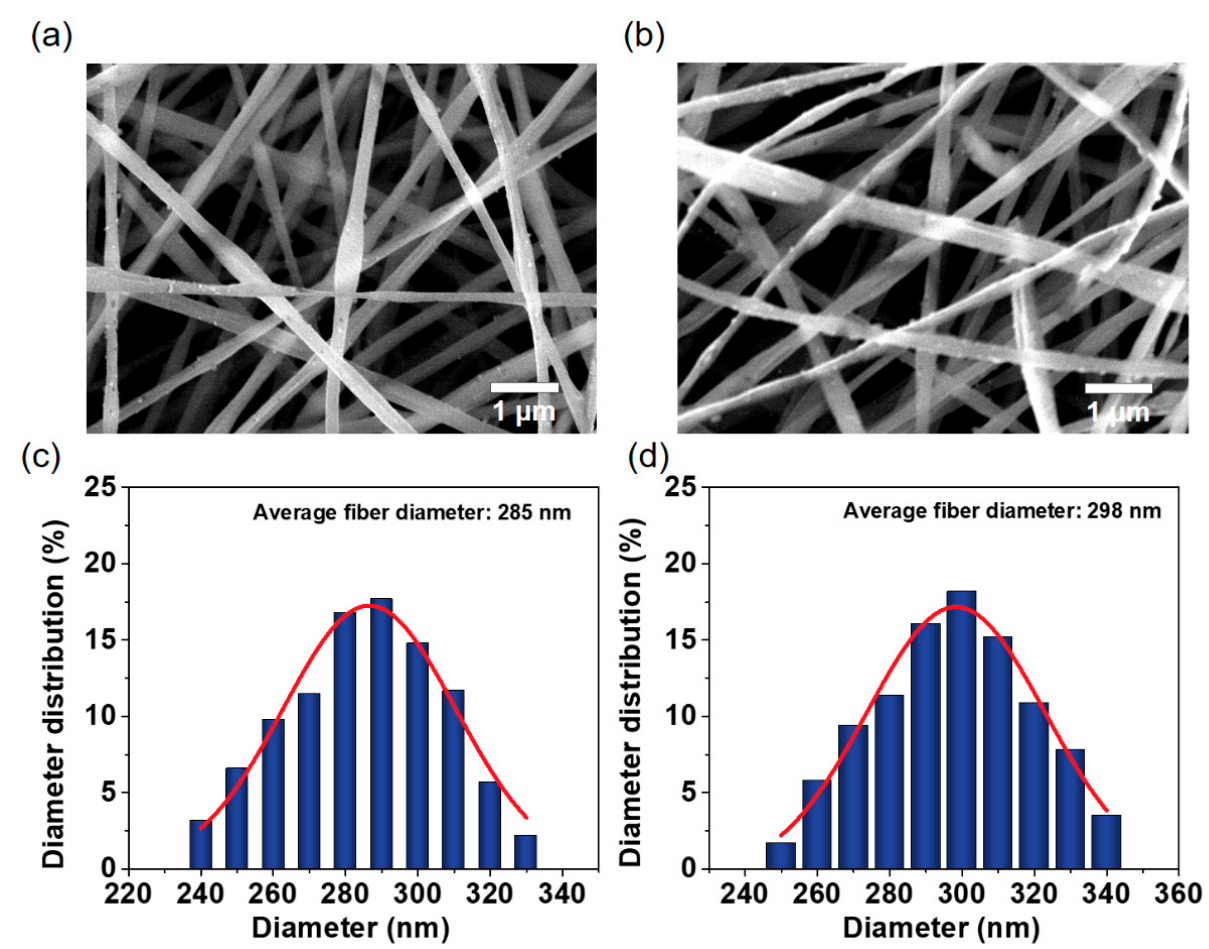
Figure 2. SEM images of ( a ) SF/PVA BNM and ( b ) G-SF/PVA BNM. Diameter distribution of ( c ) SF/PVA BNM and ( d ) G-SF/PVA BNM.